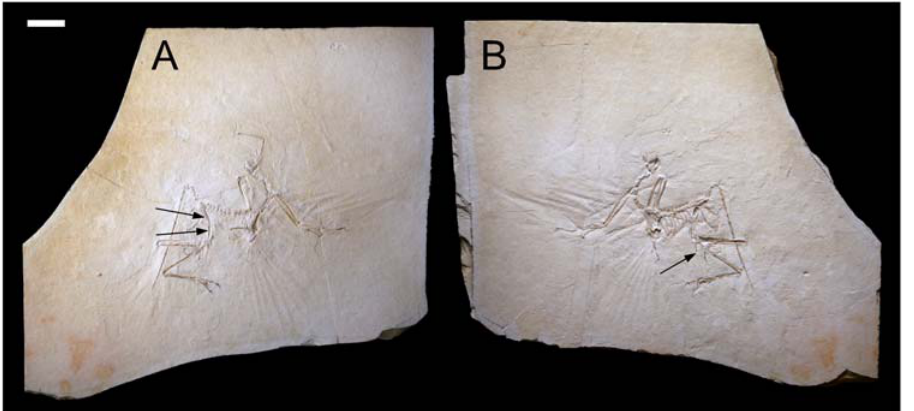
Figure 4. Slab and counterslab of the Munich Archaeopteryx (BSPG 1999 I 50). Cortical samples were extracted from the fracture faces of broken elements. (A) Main slab with arrows showing where femoral samples were extracted. (B) Counterslab showing where the fibula was sampled. Scale bar =5 cm.